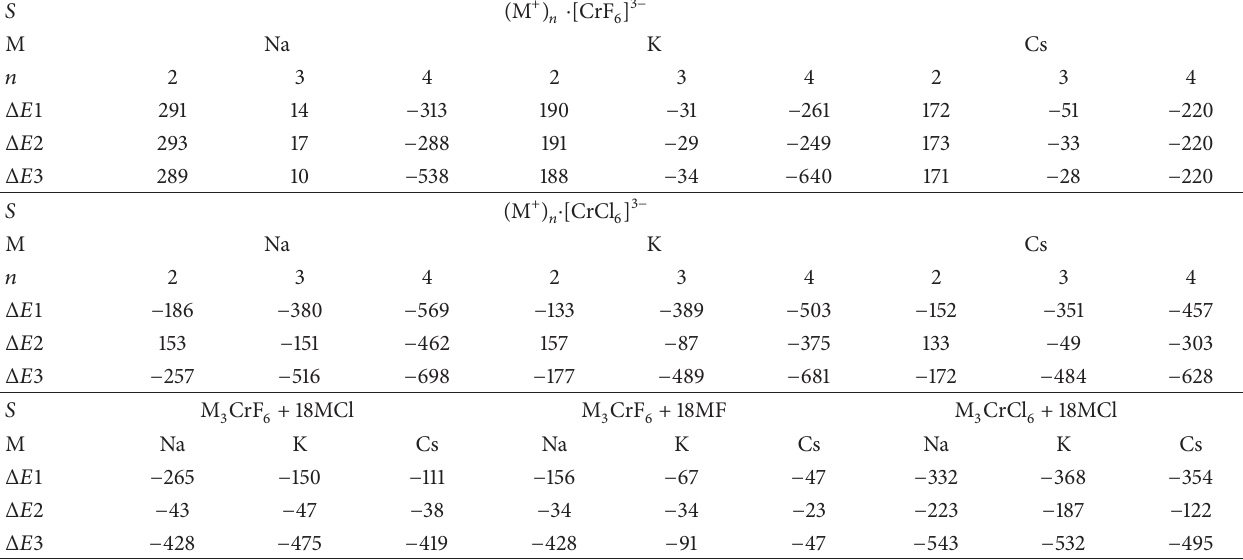
Table 1: The energy parameters (kJ/mol) of the systems before and after electron transfer. Explanation in text.